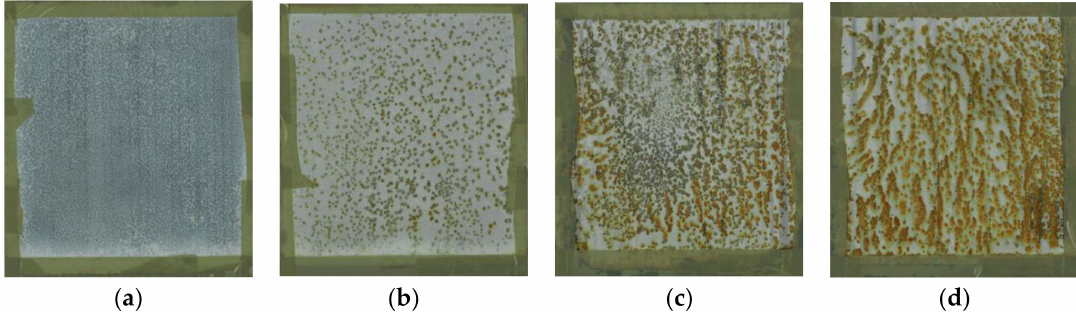
Figure 4. Images of sample surfaces with di ff erent PVC values (( a ) 41%, ( b ) 46%, ( c ) 49%, ( d ) 50%) after 7 days of water condensation chamber exposures. No magnification was used, the dimensions are the same as in actual objects.